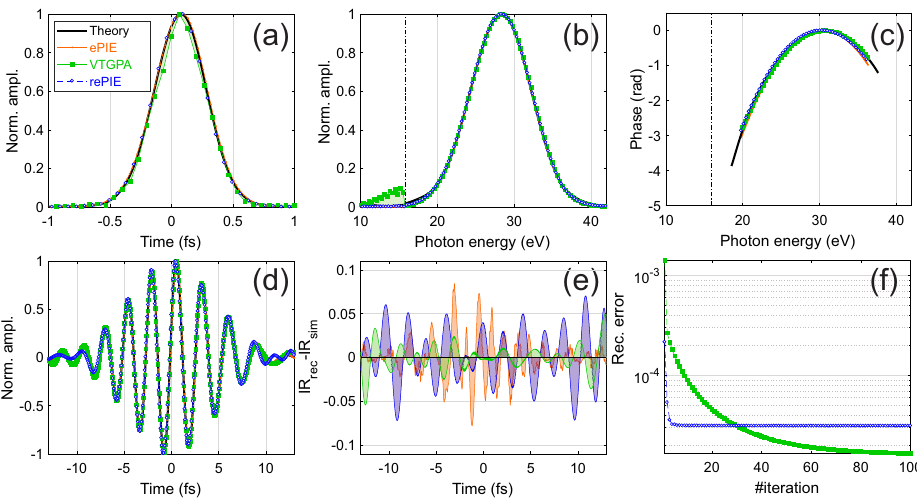
Figure 4. Attosecond pulses with spectrum centred around the 19th harmonic. ( a ) Temporal amplitude profile of the XUV pulse. ( b , c ) Associated spectra amplitude and phase. ( d ) Reconstructed IR femtosecond pulse. ( e ) Residual error between the simulated and reconstructed IR pulse. ( f ) Reconstruction error of the last 100 iterations for VTGPA and rePIE algorithms as a function of iteration number. In all the figures, orange full dots represent the ePIE results, green squared marks show the VTGPA results, while the rePIE output is represented by the blue open